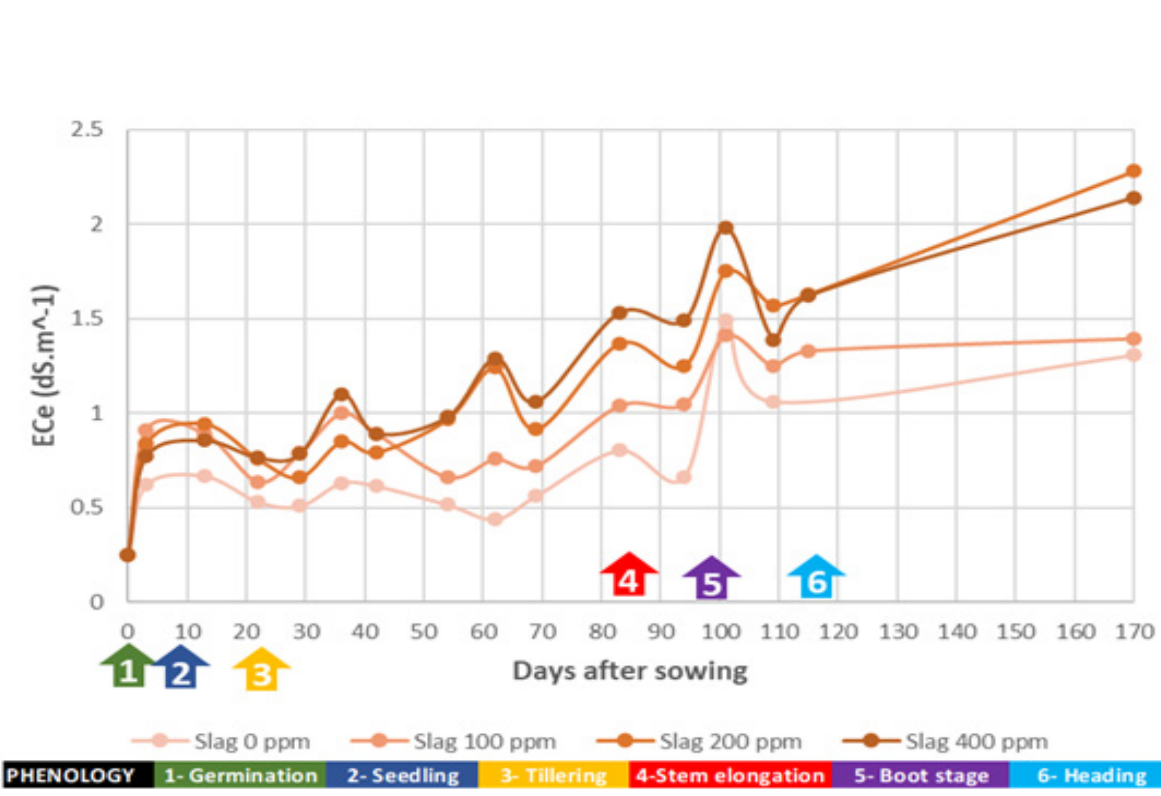
Figure 2 . Fluctuation of ECe ( dS.m - 1 ) for all ladle furnace slag treatments (Slag Xppm) during the field stage of the experiment.